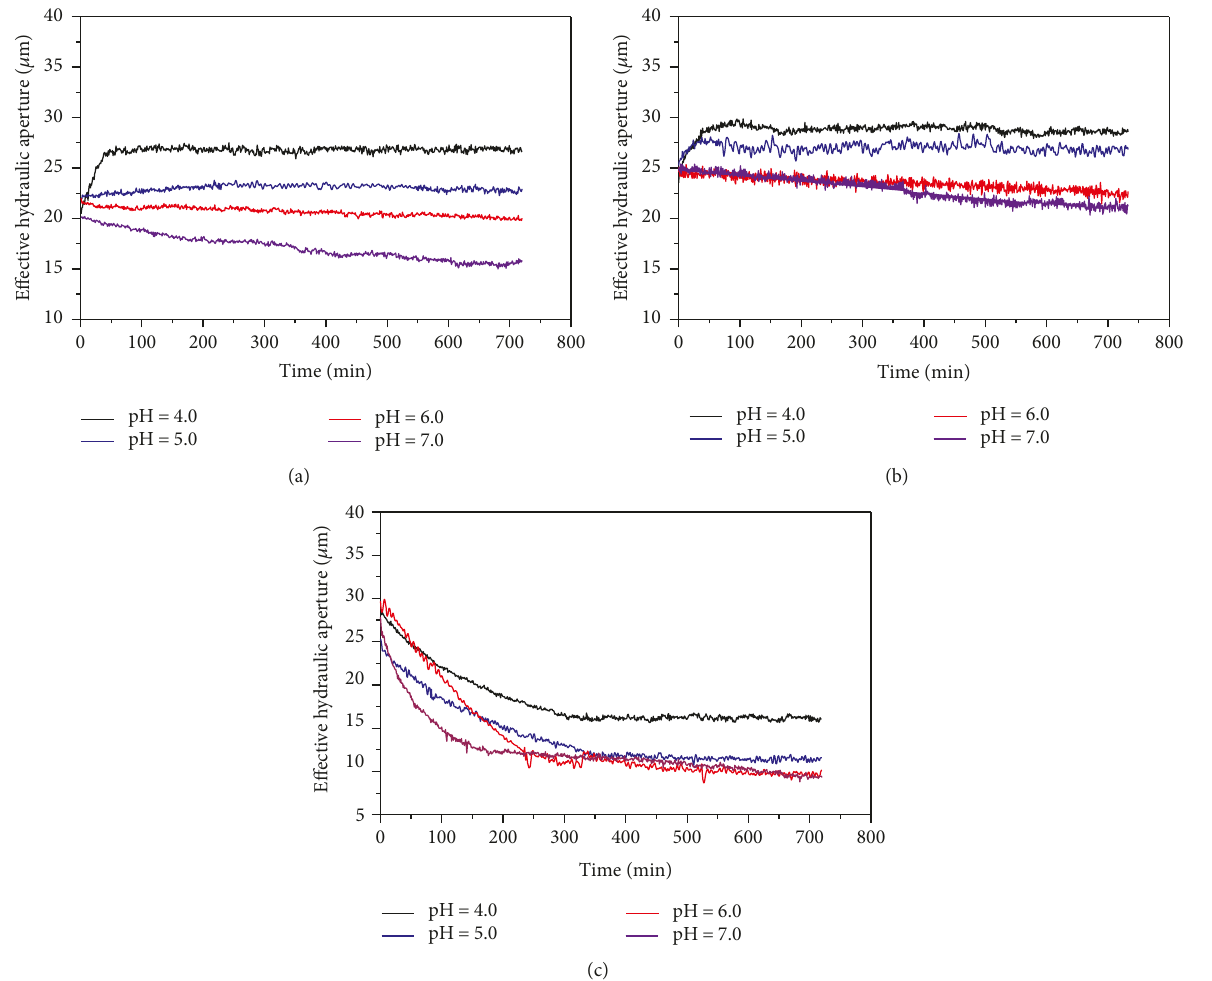
Figure 5: E ff ective hydraulic aperture evolution with time under di ff erent fl uid acidity conditions for various shales. (a) Longmaxi shale, (b) Green River shale, and (c) Marcellus shale. When fl uid pH =4.0 and 5.0, there is a monotonic increase in e ff ective hydraulic aperture until a maximum aperture is observed for Longmaxi shale and Green River shale. The e ff ective hydraulic aperture keeps a decrease trend for Longmaxi shale and Green River shale when pH=6.0 and 7.0 while all fl uid acidity conditions for Marcellus